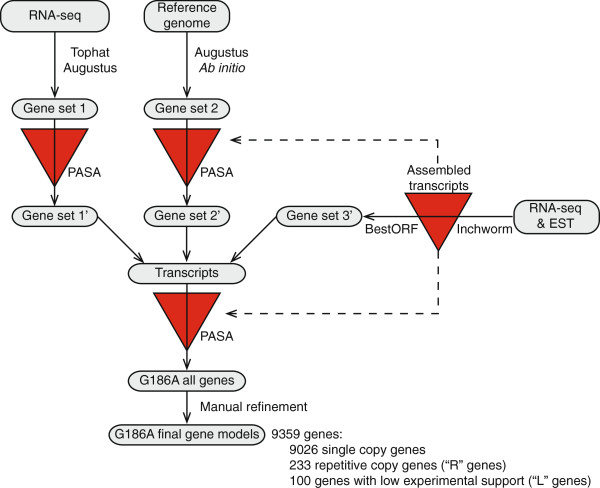
Transcriptional evidence-based pipeline for assembly of Histoplasma G186A gene models. RNA-seq data was used to generate spliced alignment models to the reference genome (gene set 1 and 2) as well as de novo assembly into contiguous transcripts (gene set 3′). Gene sets 1 and 2 were updated by PASA (red triangles) using the de novo transcript assembly. The three gene sets were integrated and subjected to an additional update using the de novo mRNA assembly. The resultant gene set was manually refined after inspection of the models for genes with unusual characteristics (introns greater than 350 bp or intergenic distances less than 500 bp). The final gene models were subsequently categorized as single copy genes, repetitive genes, or genes with low experimental support (gene models based on low numbers of RNA-seq reads).